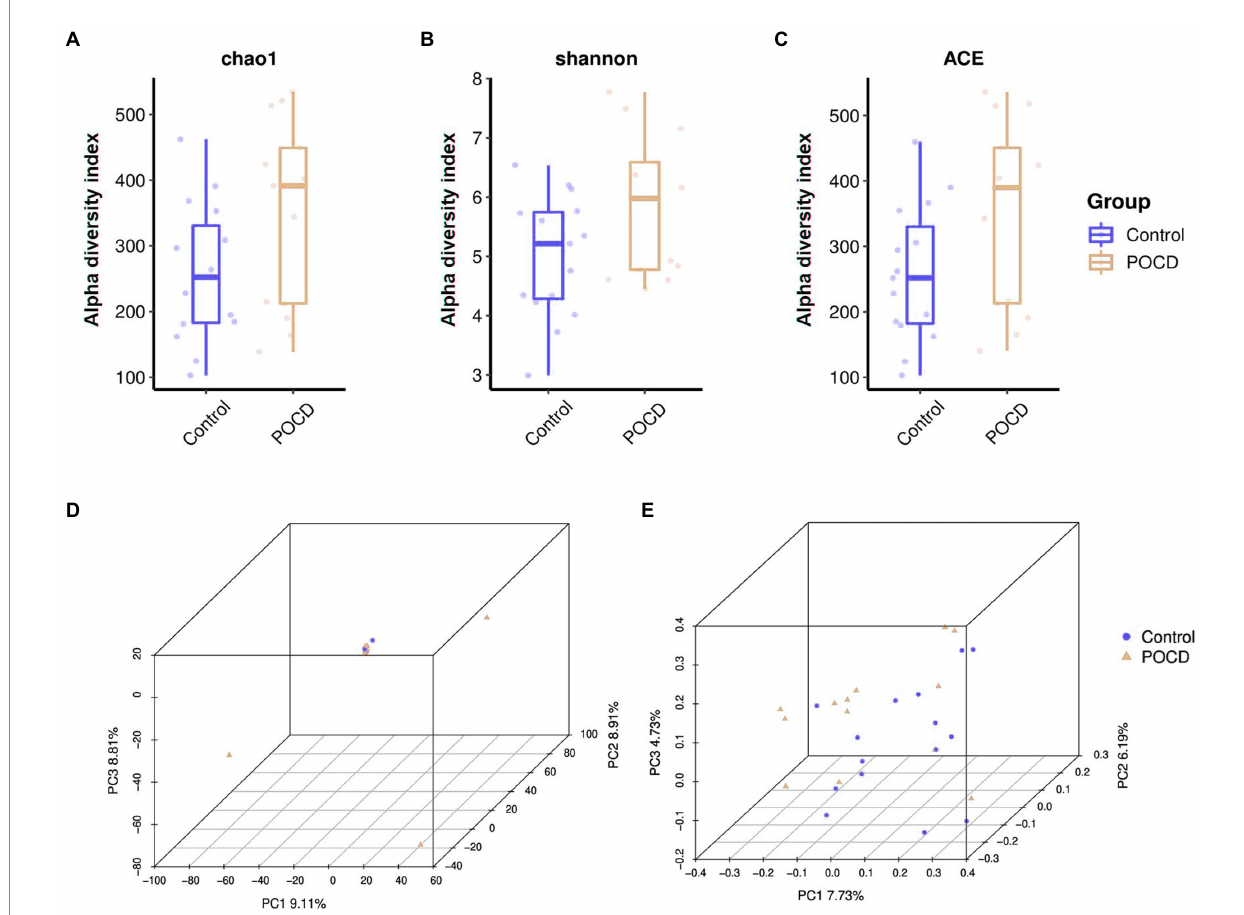
FIGURE 2 Alpha diversity and beta diversity in gut microbiota between the two groups. (A–C) There was no significant difference of alpha diversity as measured by the Chao1 diversity index ( p = 0.098). The Shannon index ( p = 0.065) and ACE index ( p = 0.110) indicated species diversity and evenness, did not show significant differences. (D,E) There was no difference between the two groups measured by PCA and